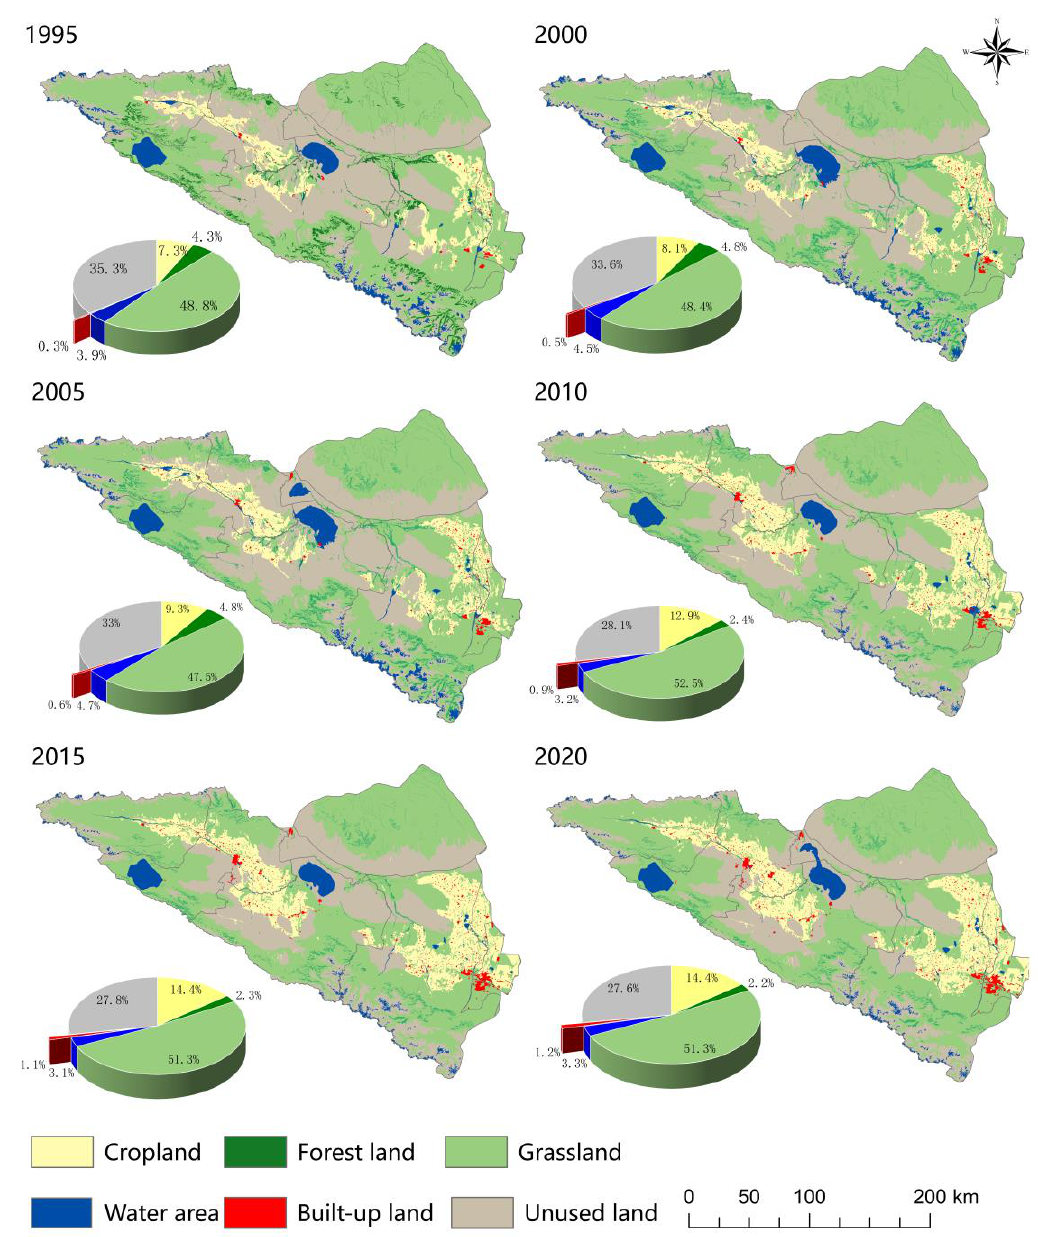
Figure 4. Distribution map of land-use change of the Ebinur Lake Basin from 1995 to 2020 Table 3. Land-use area percentage and dynamic degree in the Ebinur Lake Basin from 1995 to 2020.